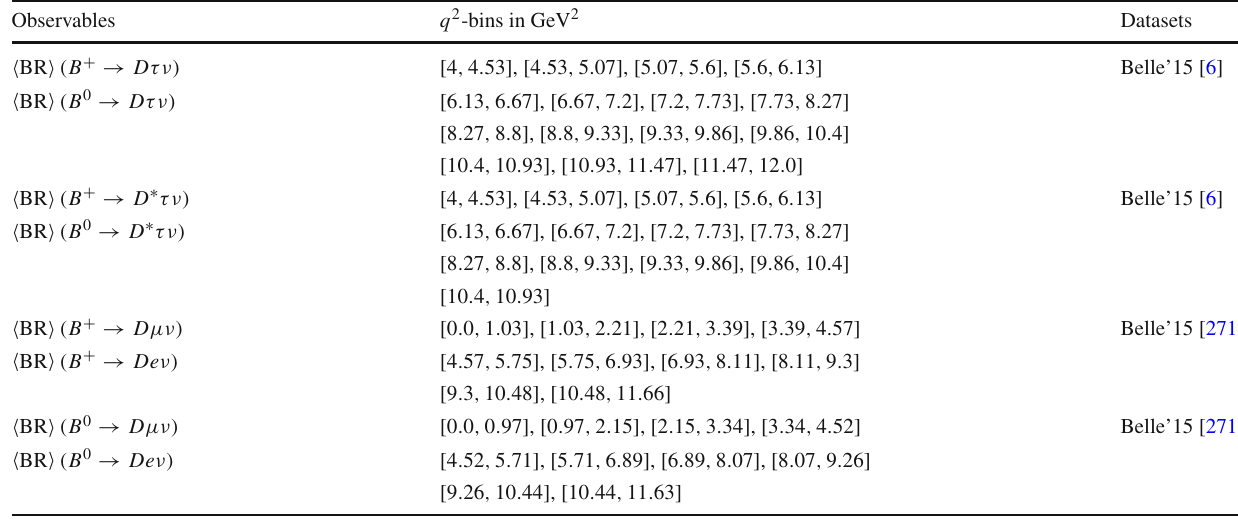
Table 9 Datasets of binned branching fractions in B → D ( ∗ ) (cid:4)ν Observables q 2 -bins in GeV 2